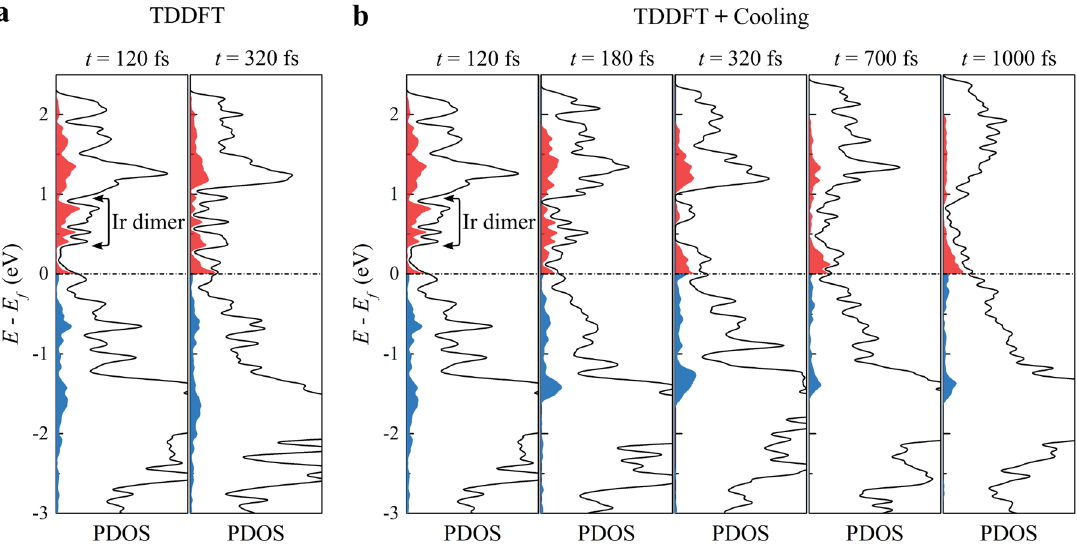
Fig. 2 Evolution of excited carriers. Partial density of states (PDOS) of eight-pair Ir – Ir dimers from TDDFT simulation without carrier cooling ( a ) and TDDFT simulation with carrier cooling ( b ). Red (blue) shaded areas represent 3% electronic occupations (hole occupations) where 40% Ir – Ir-dimerized antibonding states are occupied by photoexcited electrons at t = 120 fs.